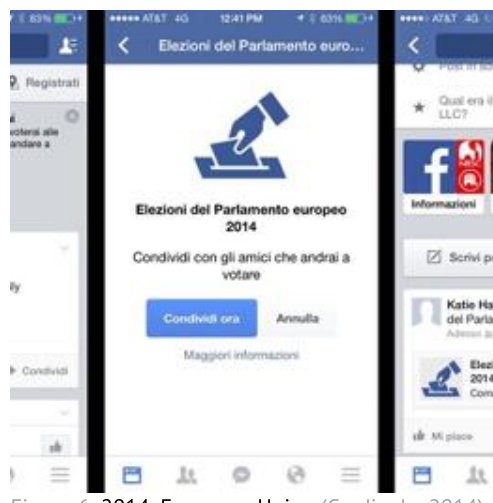
Figure 6: 2014, European Union (Cardinale,